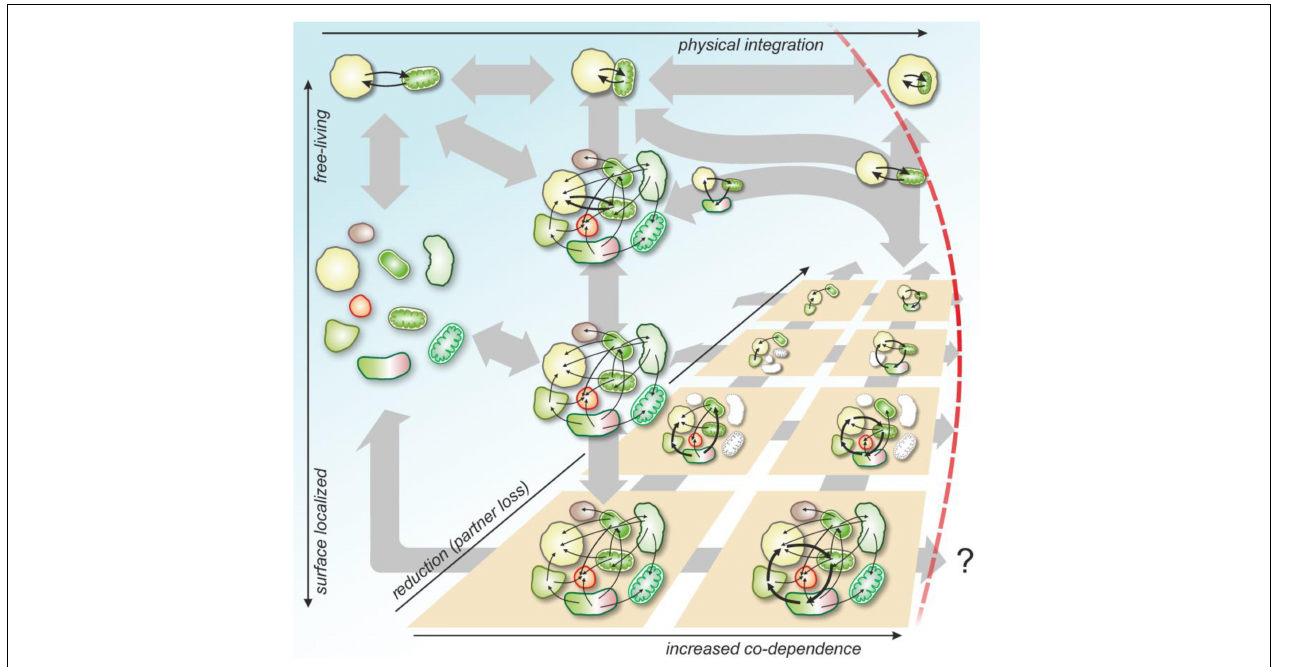
FIGURE 3 | Possible routes for microbial communities to achieve transition in individuality. Communities may be either surface bounded (brown panels) or not (blue phase). Metabolic, cooperative, and inhibitive interactions evolve between members (for sake of simplicity, arrows denote unspecified positive ecological interactions). Certain interactions may strengthen, if selection favors them (thicker arrows), certain partners may be lost due to replacement, competition or instability (grayed out cells). A symbiotic pair may emerge from free-living cells, from a loosely coupled metabolic network or from a surface-bound biofilm. The organized spatiotemporal structure of biofilms bound to surfaces may facilitate co-dependence and the emergence of cooperative cycles (or pairs), that can be selected for at the biofilm level (if biofilms compete as lineages). A transition in individuality (red separator) happens when integration of the endosymbiont becomes irreversible and the pair can only reproduce together. Alternatively (and putatively), a biofilm (or any community) may evolve means to stably replicate as a group and waive the replication of its independent cells (question mark). Ecological and evolutionary timescales are not